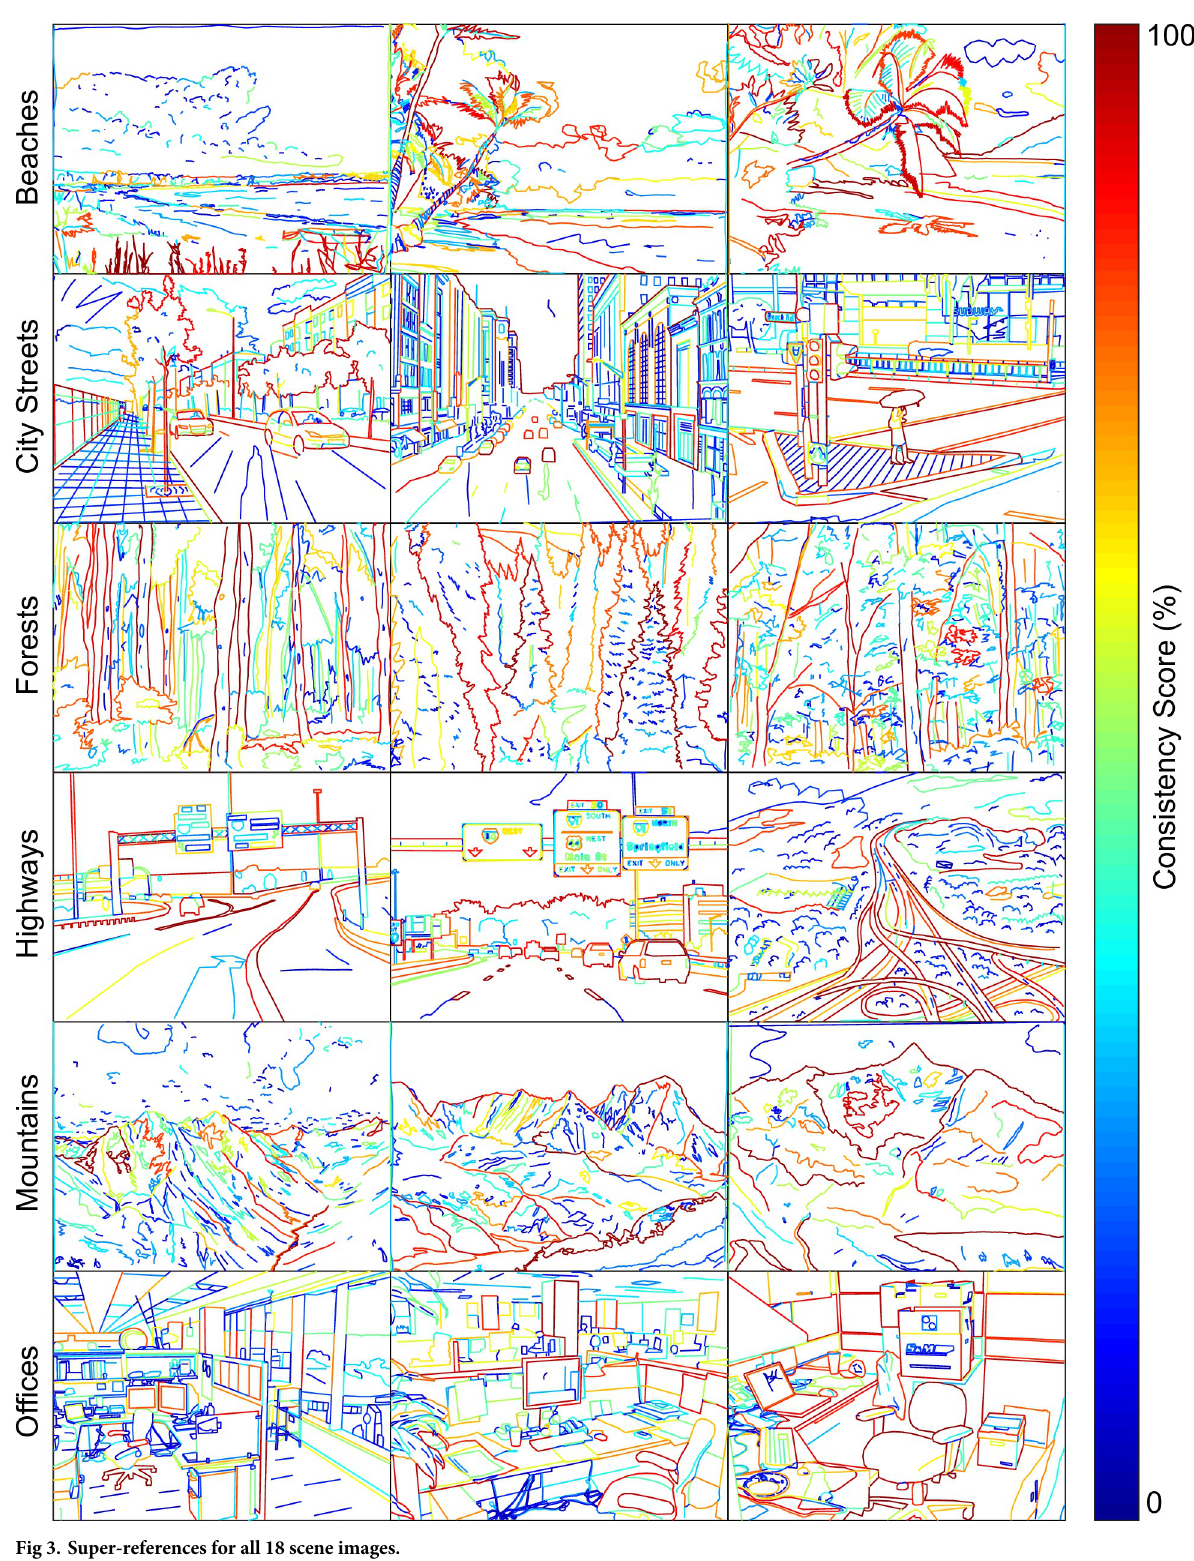
Fig 3. Super-references for all 18 scene images.